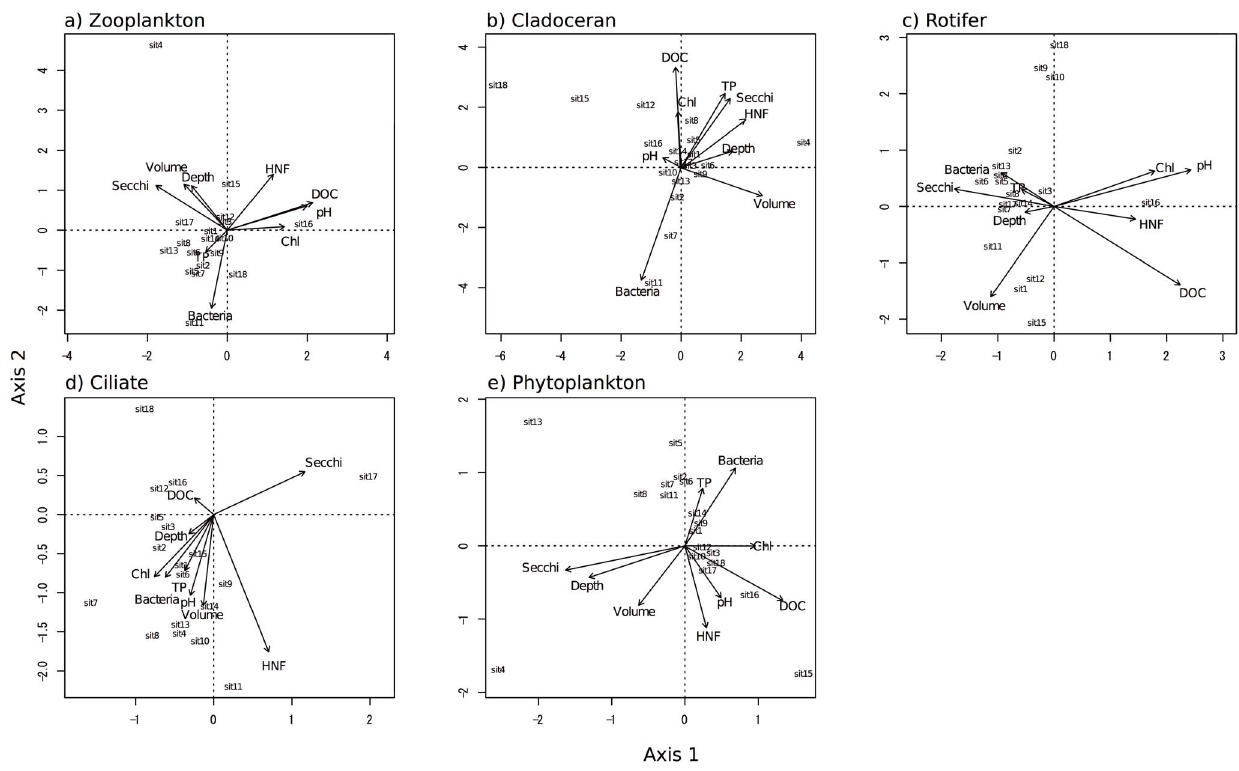
Figure 2. Canonical correspondence analysis results for whole zooplankton and plankton taxonomic groups. Graph showing canonical correspondence analysis results for whole zooplankton (a) and plankton taxonomic groups, namely, cladocerans (b), rotifers (c), ciliates (d), and phytoplankton (e). TP, total phosphorus; DOC, dissolved organic carbon in water; Chl, chlorophyll a ; HNF, heterotrophic nanoflagellates. Each numbered point indicates an individual